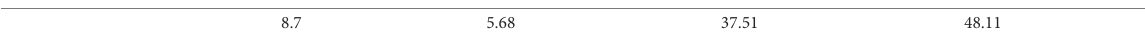
TABLE 5 Sentiment analysis of anthropomorphic dimensions.